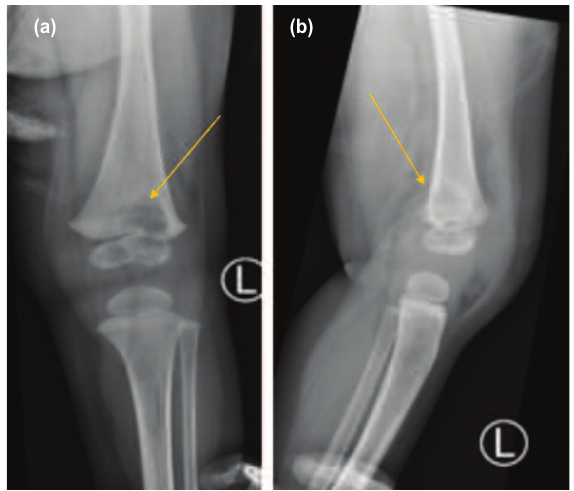
Metaphyseal involvement with extension across the Fig. 2: physeal plate with knee swelling seen on (a) left femur AP view, (b) left femur lateral